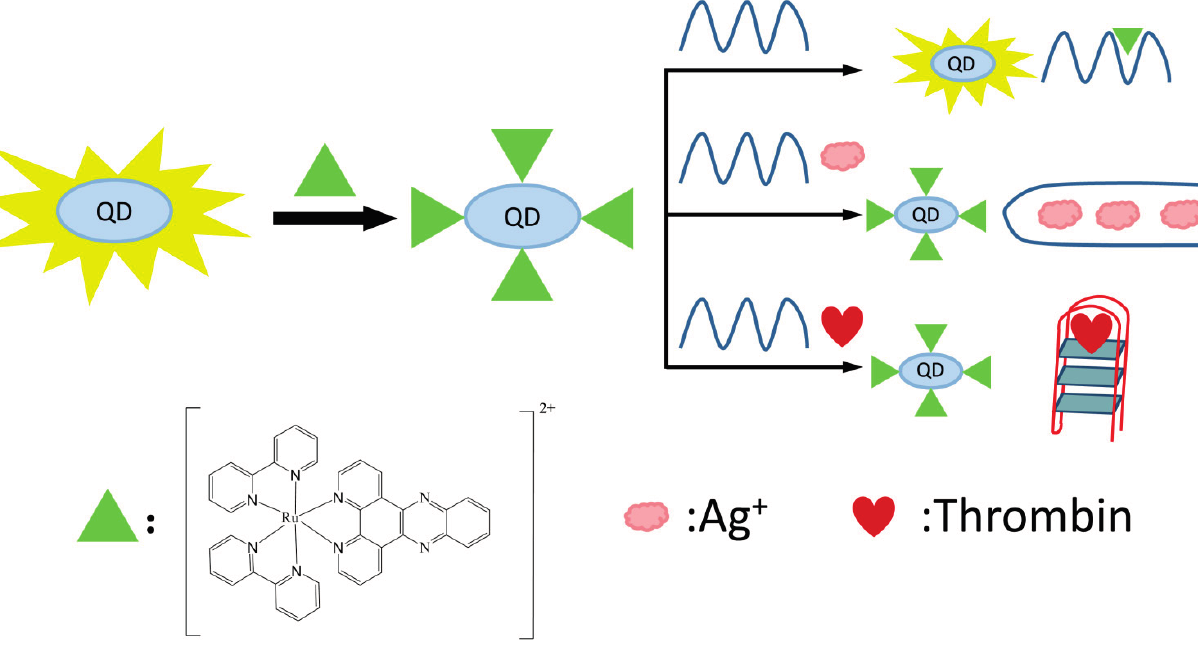
(dppz)] 2+ and quantum dot (QD). Reprinted with 2